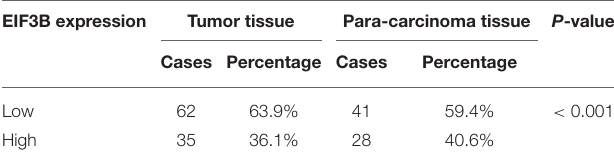
TABLE 1 | The expression of EIF3B in pancreatic cancer tissues and para-carcinoma tissues revealed in immunohistochemistry analysis. EIF3B expression